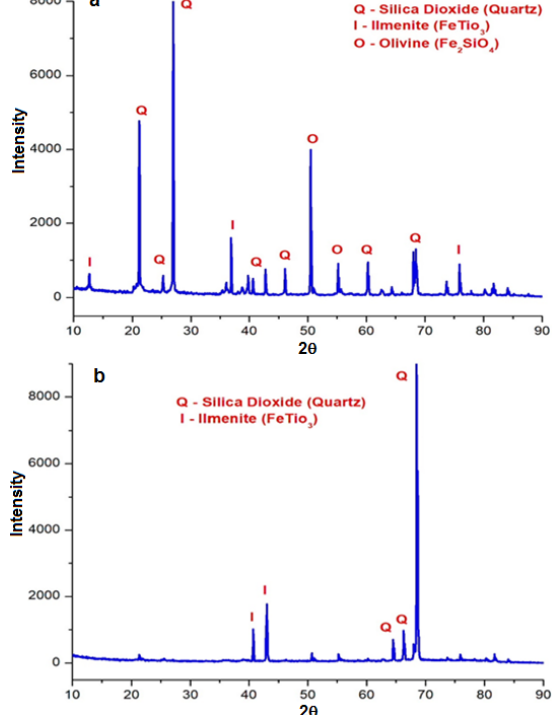
Figure 10. XRD analysis of ( a ) Fine silica sand, and ( b ) Coarse silica sand.